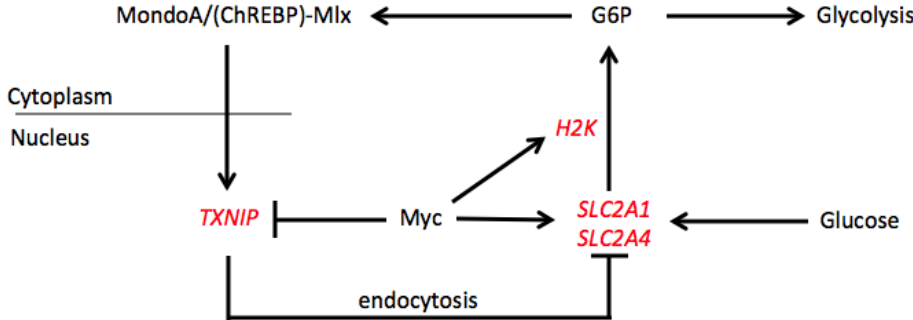
Figure 3. The Myc and Mlx Networks cross-talk to modulate TXNIP and glycolysis . The G6P-mediated cytoplasmic → nuclear transport of MondoA-Mlx heterodimers (and probably ChREBP-Mlx heterodimers as well) facilitates their binding to tandem ChoREs in the TXNIP gene’s promoter and up-regulates its expression [30,32,85,88]. Among the functions of TXNIP is to enhance endocytosis of the Glut1 and Glut4 glucose receptors encoded by SLCA1 and SLC2A4 genes [86,89]. Myc down-regulates TXNIP in part by displacing MondoA/ChREBP-Mlx heterodimers at ChoREs [87]. Myc also directly facilitates glucose uptake via binding to E boxes in the proximal promoters of the SLC2A1 and SLC2A4 genes and further drives glycolysis by a similar induction of the H2K gene, whose encoded protein, hexokinase 2, is one of the rate-limiting enzymes of glycolysis [52,65]. Genes that are direct targets for members of the Myc and/or Mlx Networks are shown in red.